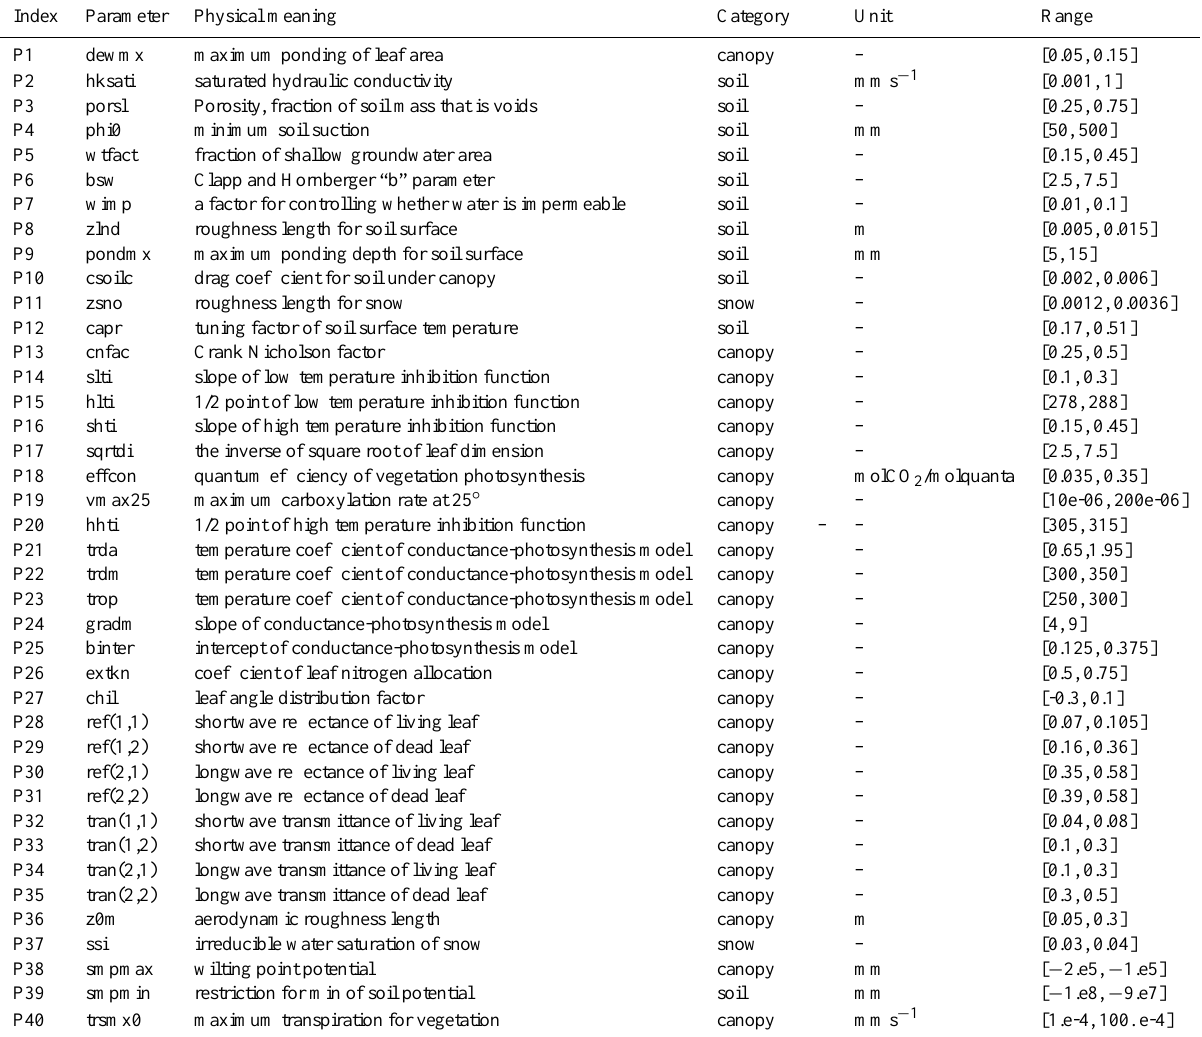
Table 2. Adjustable parameters and their ranges.